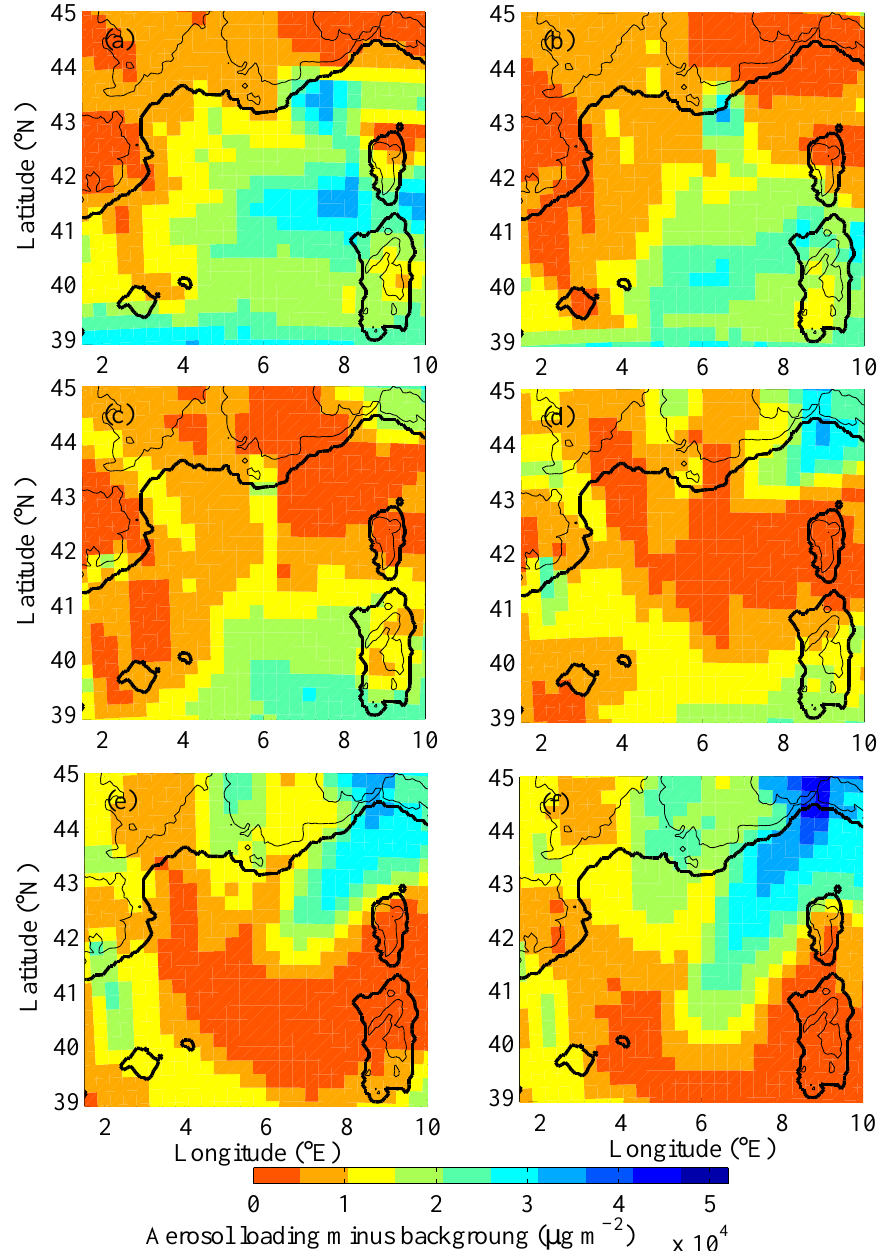
Fig. 17. Amount of aerosol in µ g m − 3 transported by the Mistral, Tramontane and Ligurian outflow in addition to the background aerosol loading (i.e. difference of the total aerosol loading minus the background aerosol loading). The panels correspond to 0600, 0900, 1200, 1500, 1800, 2100 UTC on March 24, 1998.